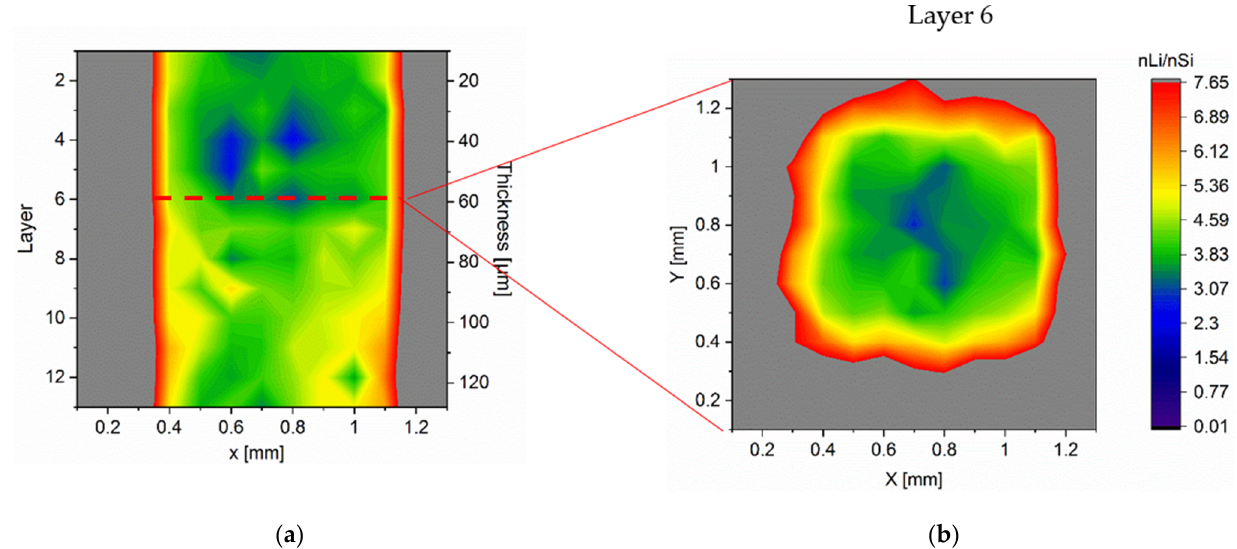
Figure 9. Lithium distribution of a Si/C micropillar lithiated at 1 C: ( a ) cross-sectional concentration profile of the micropillar at position y = 0.7; ( b ) horizontal layer 6 of the micropillar cross-sectional mapping.